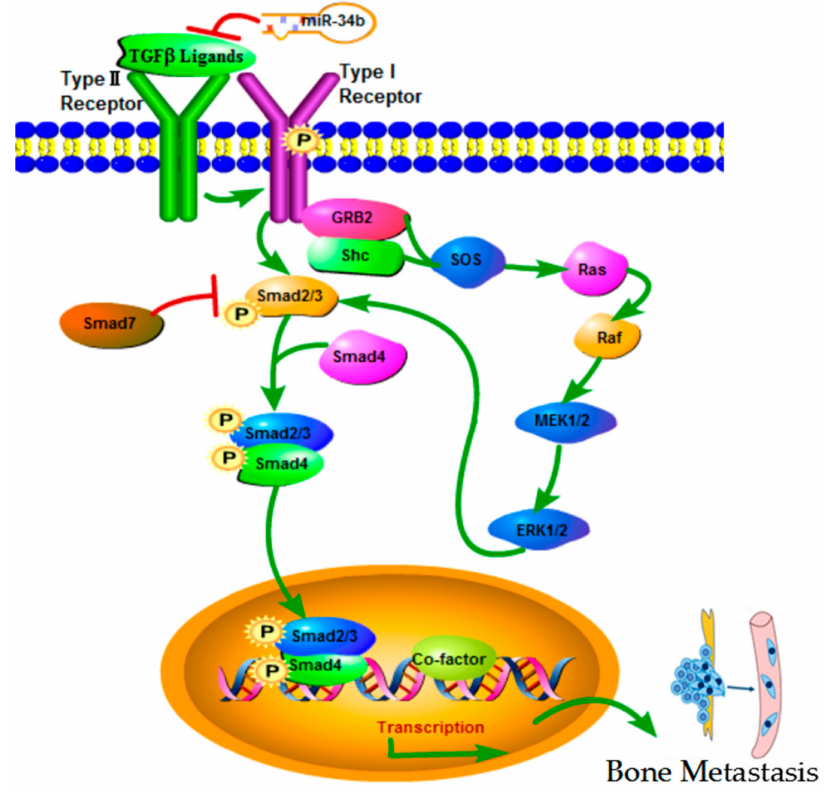
Figure 12. TGF- β signaling pathway. TGF- β superfamily of cytokines bind to type I receptors and type II receptors at the cell surface, thereby forming a tetrameric complex. Binding of TGF- β 1 to its receptor II activated the TGF- β receptor type I kinase, resulting in phosphorylation of the downstream signal transducer Smad2/3(R-SMADs). Phosphorylated R-SMADs forms a complex with a common